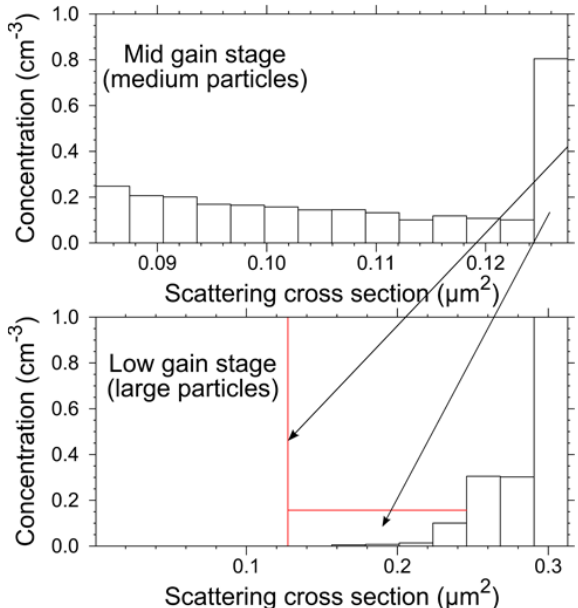
Fig. 7. The two plots show details at a PCASP gain stage boundary created by reprogramming a PCASP to zoom in on this area of inter- est. The red vertical bar shows the maximum extent of the overlap between the two gain stages, below which we expect to see no par- ticles. The horizontal red bar shows the concentration which would be measured if the excess in the top channel of the mid gain stage were redistributed above the overlap point of the low gain stage. Note that the top bin of the low gain stage goes off the scale to a concentration of 2.47cm − 3